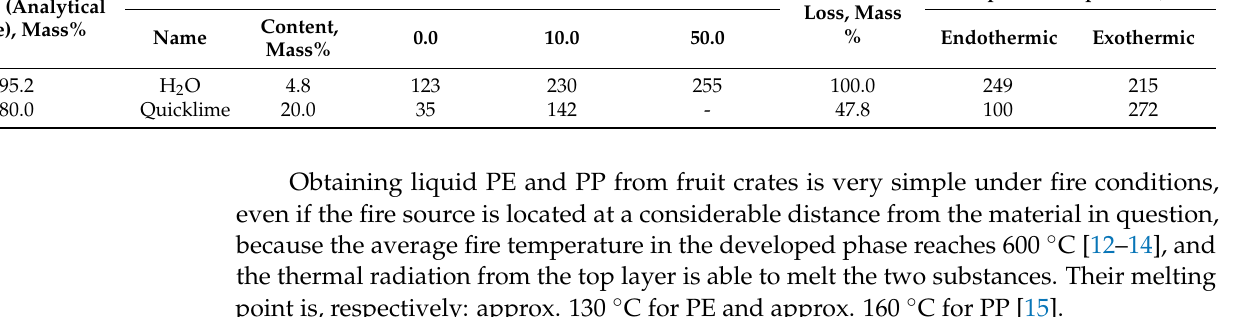
Table 1. Influence of selected ammonium nitrate (AN) additives on the temperature of the mixture’s decomposition initiation. AN Content (Analytical Grade),